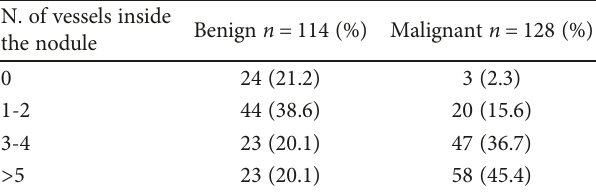
Figure 1: Solid nodule in the left lobe: images acquired with the fi ve modes: grayscale US (a), monochrome (b) and colour (c) SMI, CD (d), and PD (e). Monochrome and colour SMI showed microvascular fl ow in greater detail compared to CD or PD. Table 1: Number of blood vessels observed inside benign and malignant nodules by SMI.